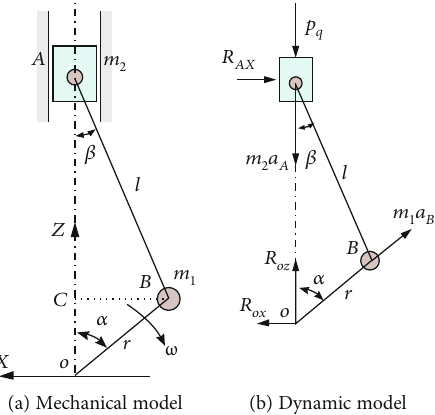
Figure 1: Kinematic and dynamic models of single-cylinder